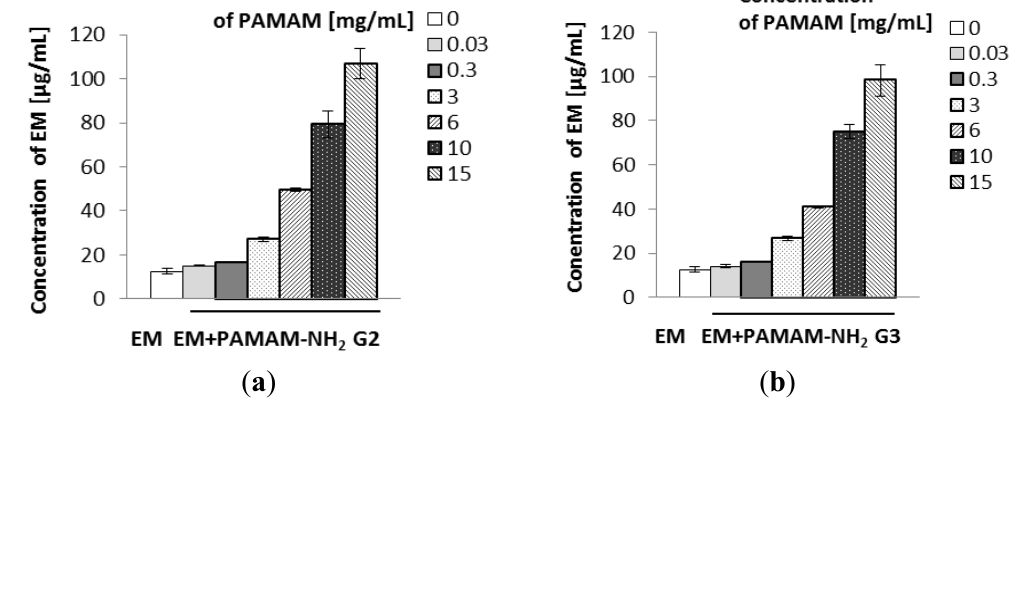
generation 3 ( b ), PAMAM-OH generation 2